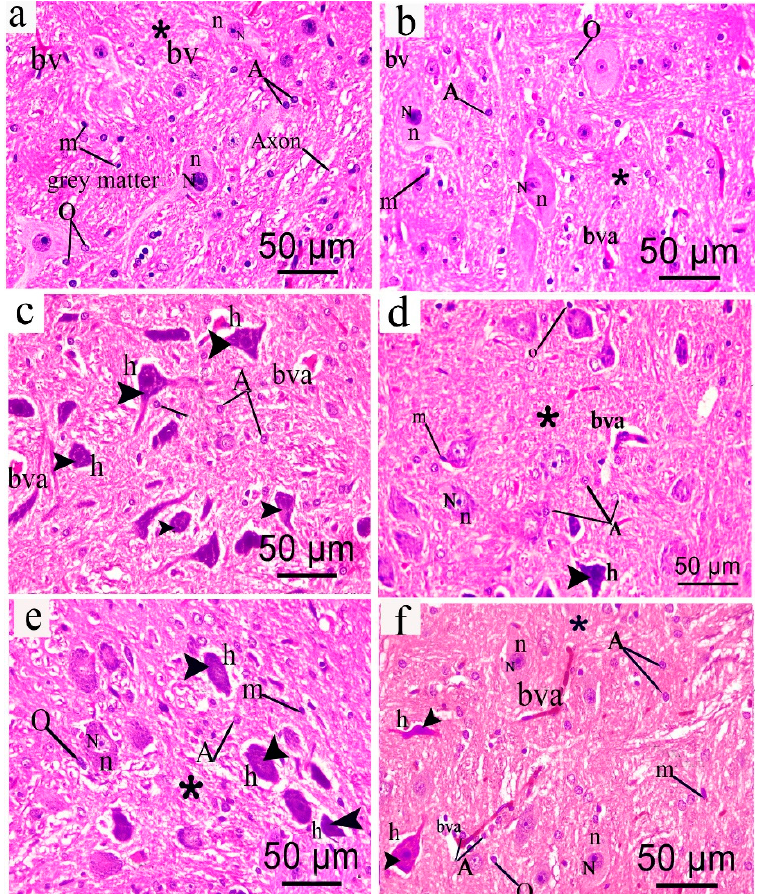
Figure 7. Representative photomicrograph (hematoxylin and eosin (H&E × 400) of brain stem sections from different groups: ( a ) Normal; ( b ) sham; ( c ) CCI ( d ) Pregabalin; ( e ) S. tetrasperma (200 mg/kg, p.o.); and ( f ) S. tetrasperma (400 mg/kg, p.o.). Arrowhead, arrow, bifid arrow, asterisk (*) illustrate normal neurons, affected neurons with dark stained cytoplasm and nuclei, perineural glial cell nuclei and neuropil, respectively. N; Nissl granule, n; nuclei, bv; normal blood vessel; bva, dilated congested blood vessel, h; halo, A; astrocyte. O; oligodentrites, m: microglial cells. Scale bar, 50 μ m.